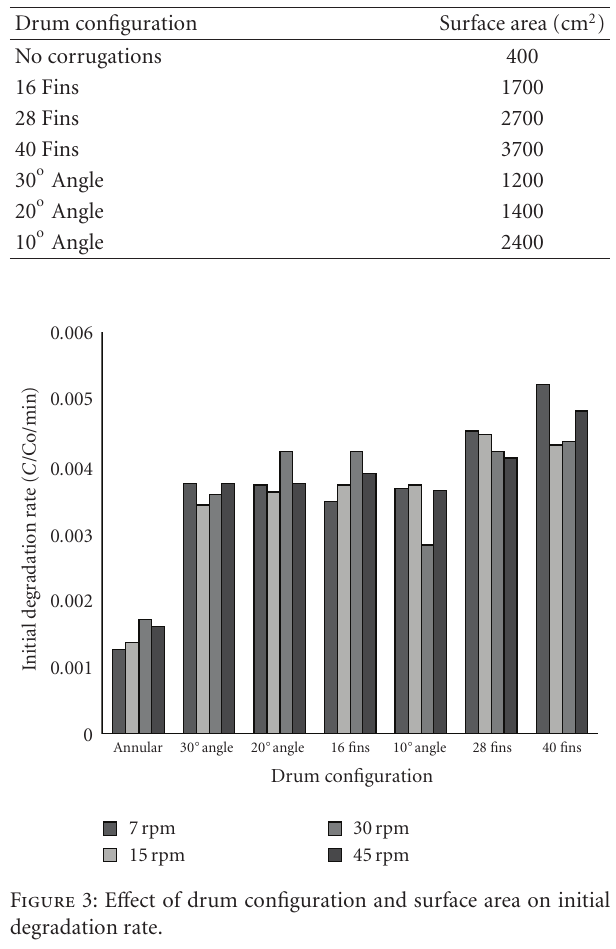
Table 1: Nominal surface area for each drum configuration.